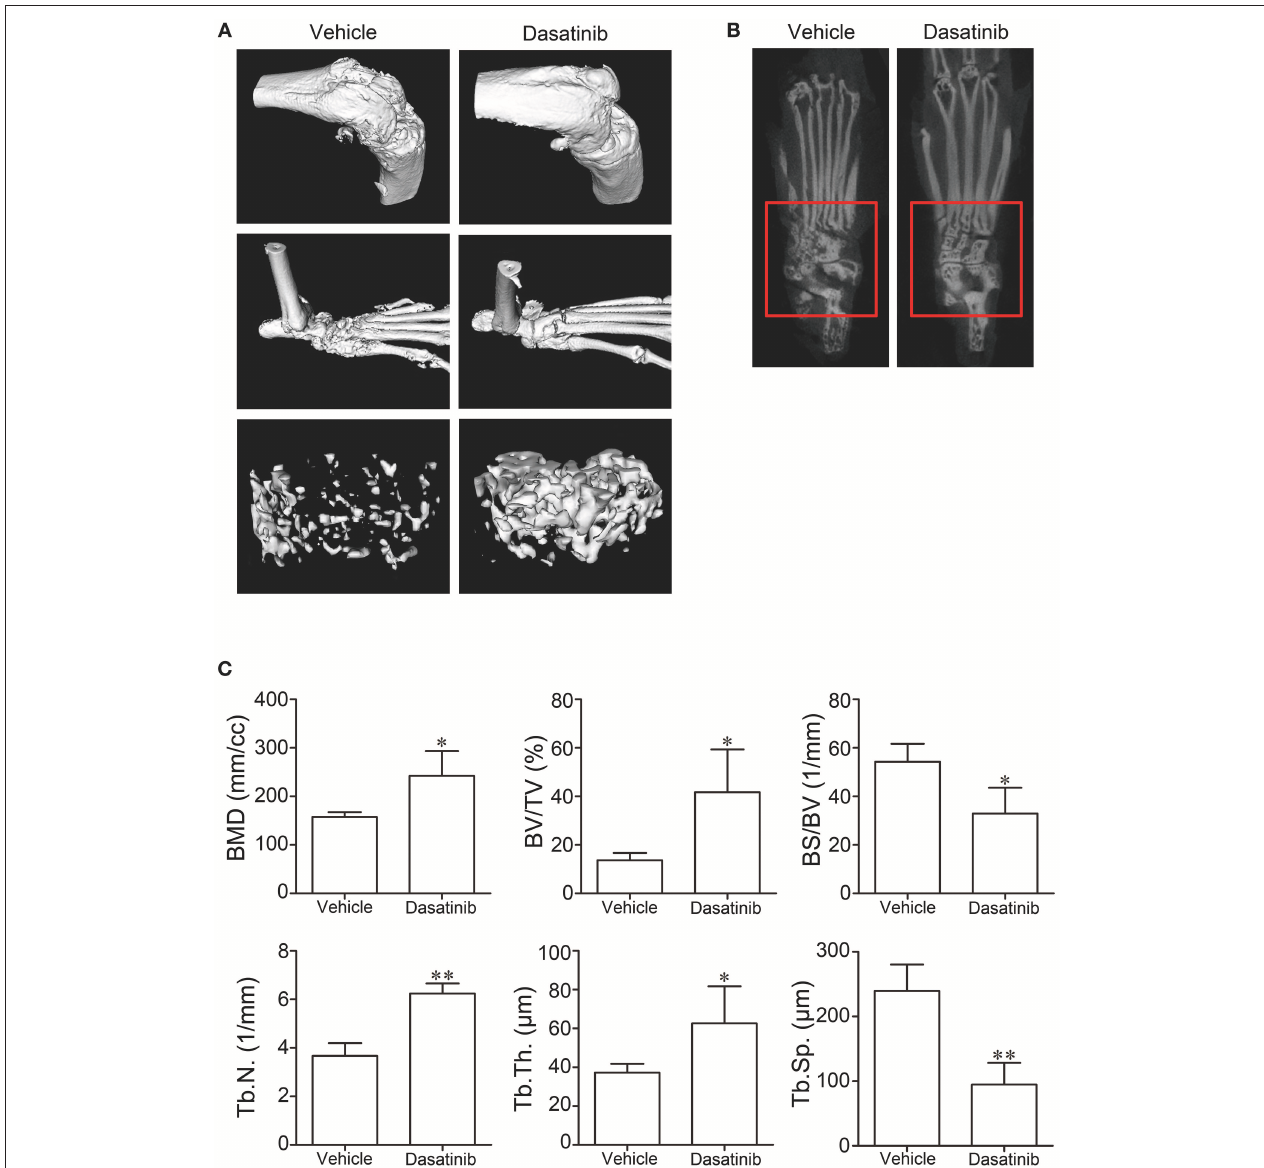
FIGURE 2 | Micro-CT was used to evaluate bone destruction in CIA mice. (A) 3D model of knee joints, ankle joints, and bone trabecular in the distal femur reconstructed using the software of the micro-CT system. (B) 2D CT tomographic images of ankle joints. (C) 3D parameters of bone trabecular in distal femur analyzed using the software of the micro-CT system. * P < 0.05, ** P < 0.01 vs. vehicle group ( n = 4 per group).